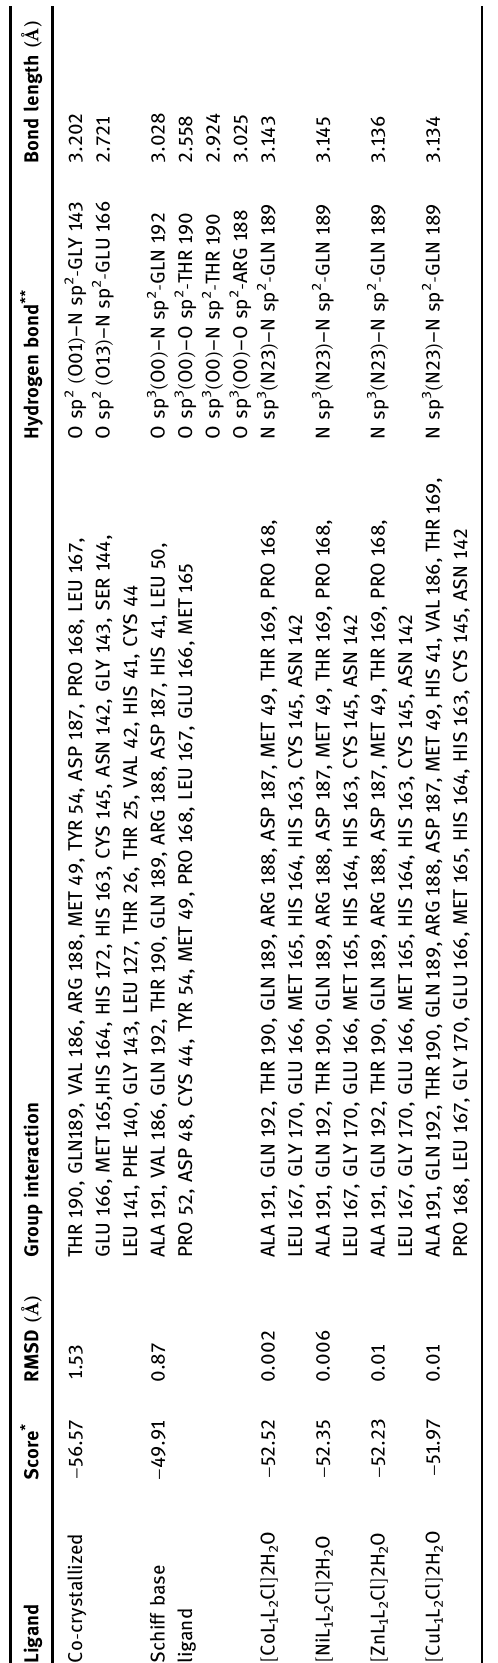
Figure 4: ( a ) Docking pose of the co - crystallized NAG and all com - pounds in the binding site of 4Z6S and ( b ) docking pose of the co - crystallized X77 and all compounds in the binding site of